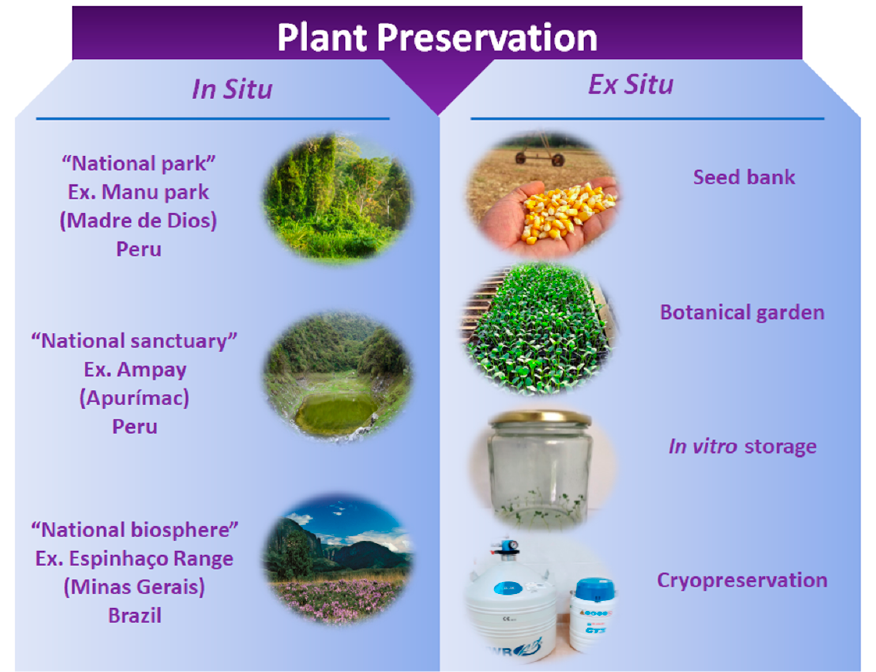
Figure 1. Basic strategies of plant preservation.